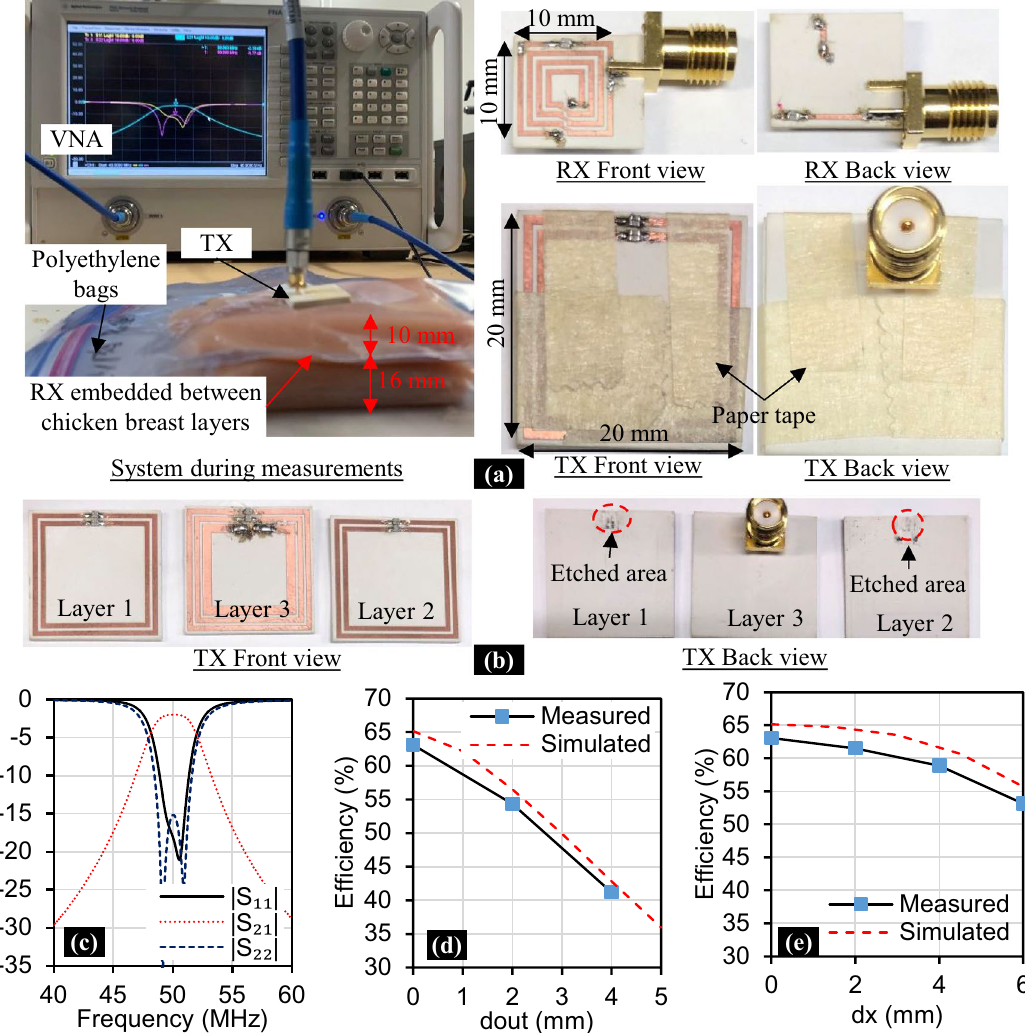
Figure 6. Fabrication and Measurements of the proposed Meta-TX WPT system. (a) System during measurement and fabricated RX/TX front and back views. (b) TX front and back views before assembly. (c) Measured S-parameters at perfect alignment. (d) Efficiency during TX separation misalignment. (e) Efficiency during lateral misalignment.